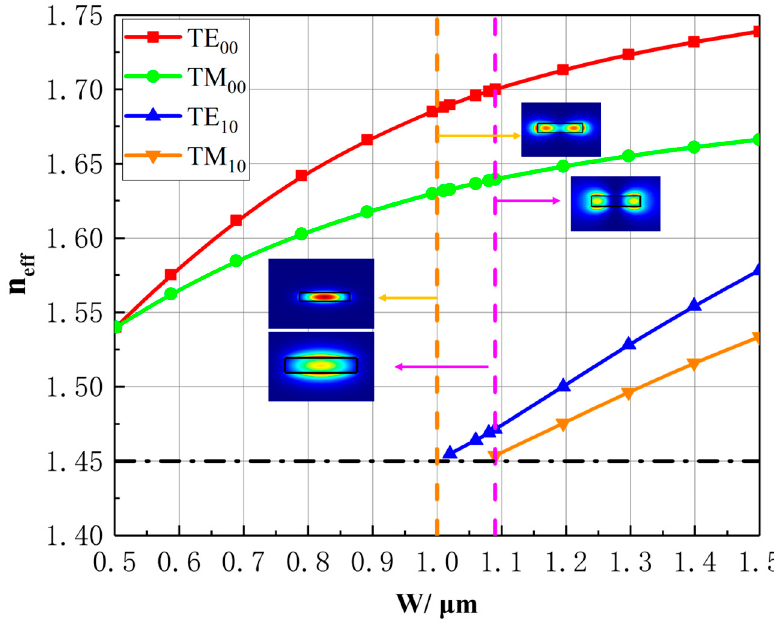
Figure 2. The simulation curve of the e ff ective refractive index under di ff erent waveguide widths.